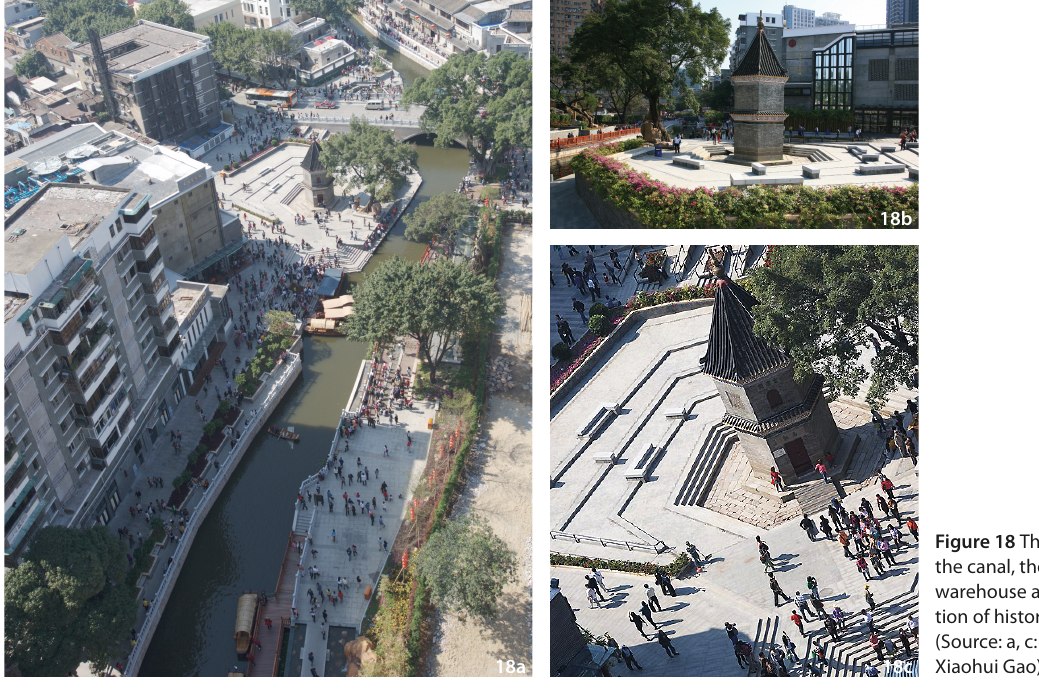
Figure 18 The dialogue between the canal, the pagoda and the warehouse after the rejuvena- tion of historic urban landscape (Source: a, c: Yongjian Guo; b: Xiaohui